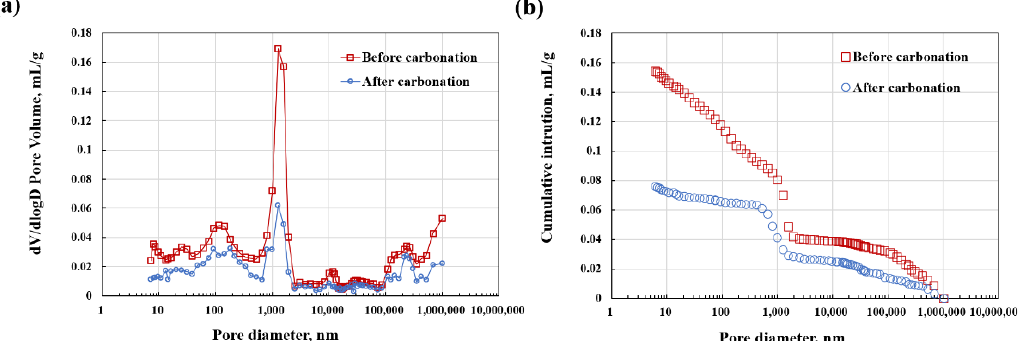
Figure 5. ( a ) Pore size distribution and ( b ) cumulative pore volume of the coating before and after carbonation.